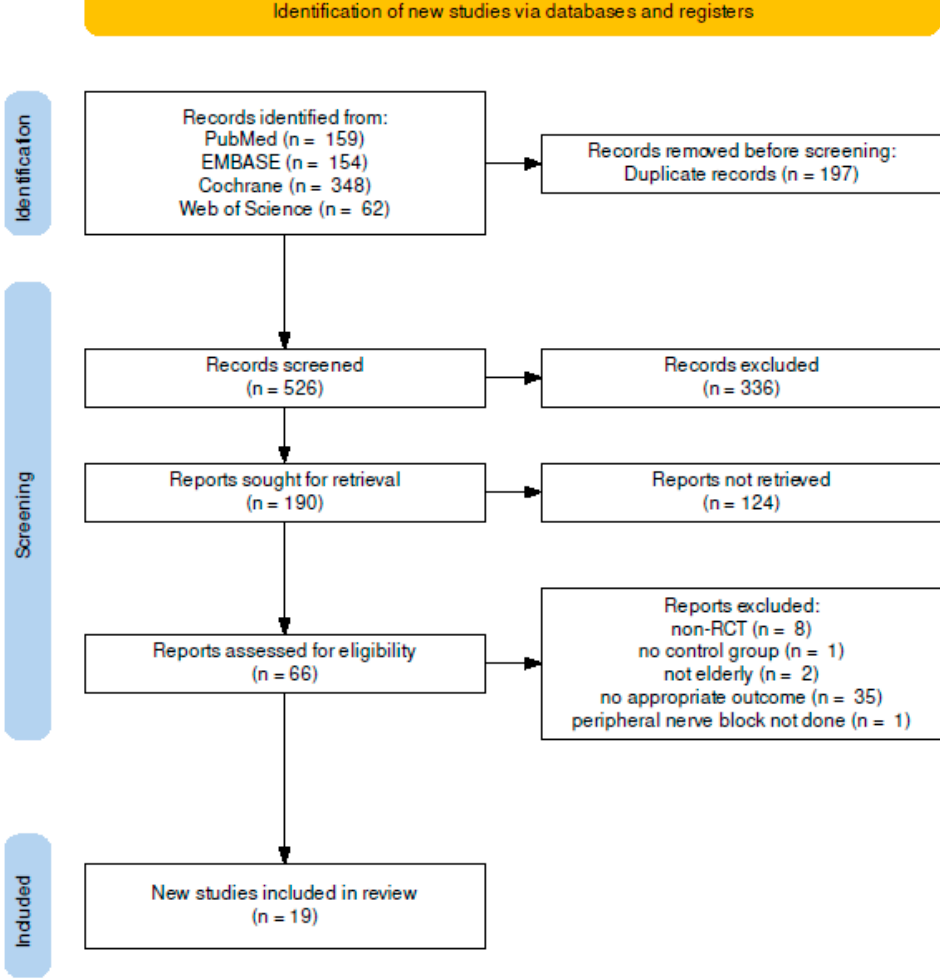
Figure 1. Flow diagram of study selection. Table 1. Study design and characteristics of included studies.